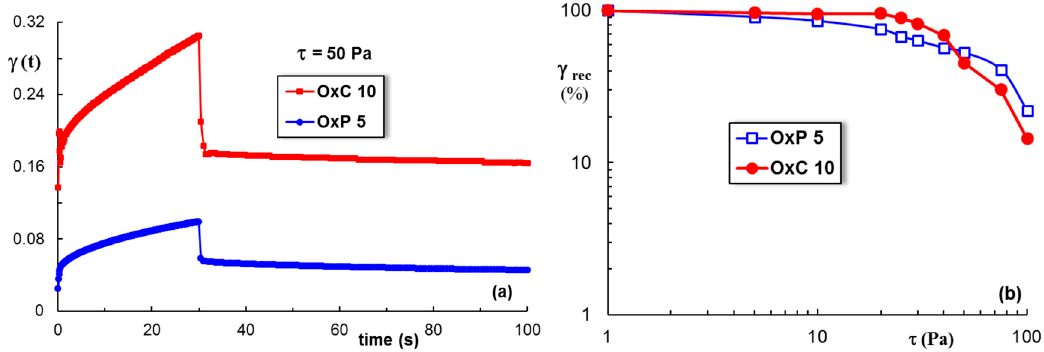
Figure 8. The behavior of OxC 10 and OxP 5 samples in creep and recovery tests: ( a ) A shear stress of 50 Pa was applied during the creep test; ( b ) the total elastic recovery ( γ rec , %) as a function of the applied shear stress during creep test for OxC 10 and OxP 5 hydrogels.